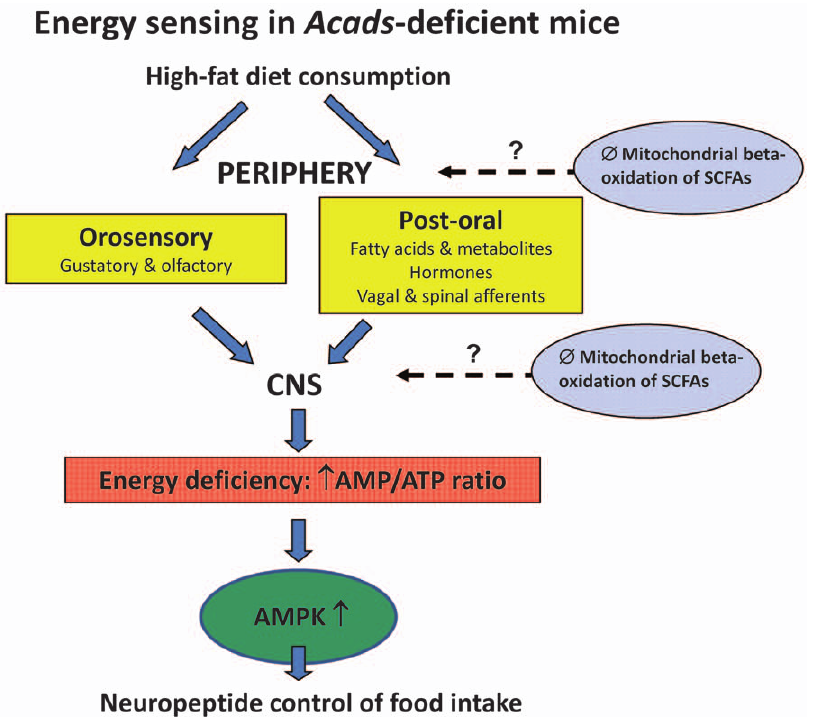
Figure 7. Energy-sensing in Acads -deficient mice. Schematic flow diagram showing possible neural processing of cues from incomplete oxidation of high-fat diet (HFD) leading to changes in food intake. In Acads -deficient mice, a lack of mitochondrial SCFA beta-oxidation has been demonstrated in both peripheral and central tissues [9] which could generate signals that contribute to energy-sensing mechanisms. Orosensory and post-oral signals generated in the periphery in response to HFD are integrated within the CNS, e.g., neurons within the hypothalamus respond to changes in energy availability. Impaired oxidation of SCFAs within the brain could also signal an energy deficiency. Hypothalamic AMPK is then activated by an increase in the AMP-to-ATP ratio, which reflects the energy status of the cell [37] and induces reciprocal modifications